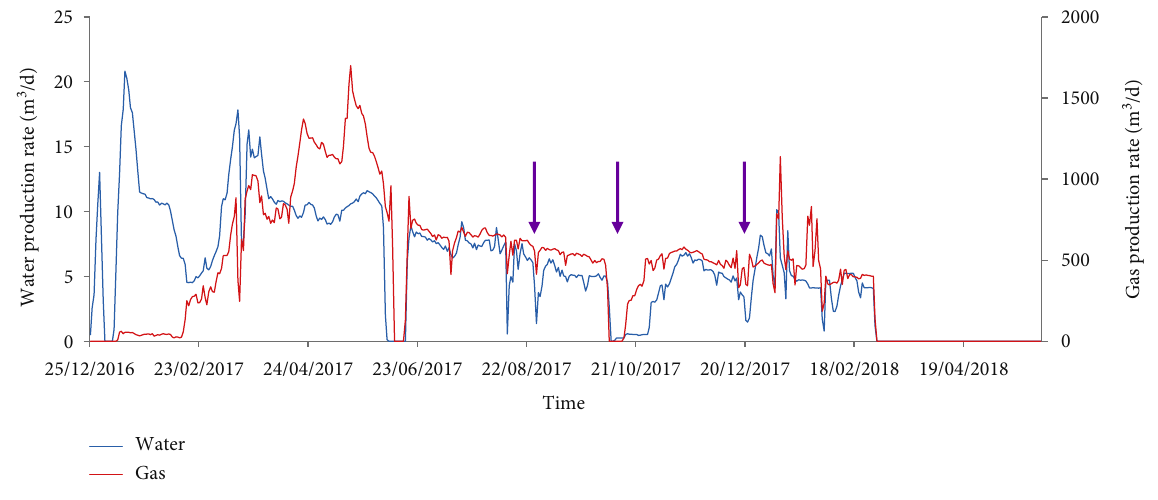
Figure 3: Fluid production curves of one typical DCBM well. Table 2: Hydrostatic column pressure and pressure gradient in the study